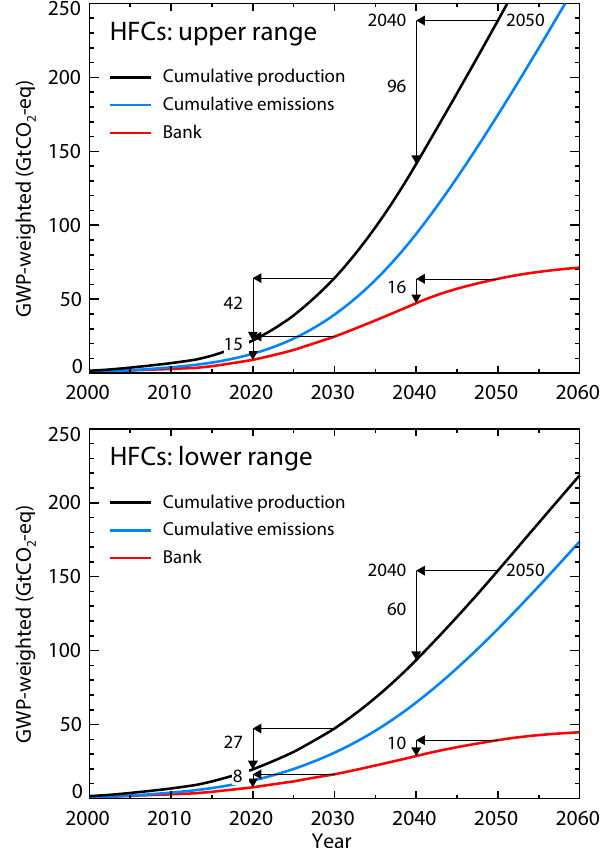
Fig. 3. Cumulative GWP-weighted production and emission and instantaneous GWP-weighted bank of the HFC upper- and lower- range scenarios from Velders et al. (2009). The cumulative produc- tion equals the sum of the cumulative emission and the instanta- neous bank. The arrows illustrate two examples of the climate ben- efits of an earlier phaseout in terms of both avoided emissions and reduced banks.